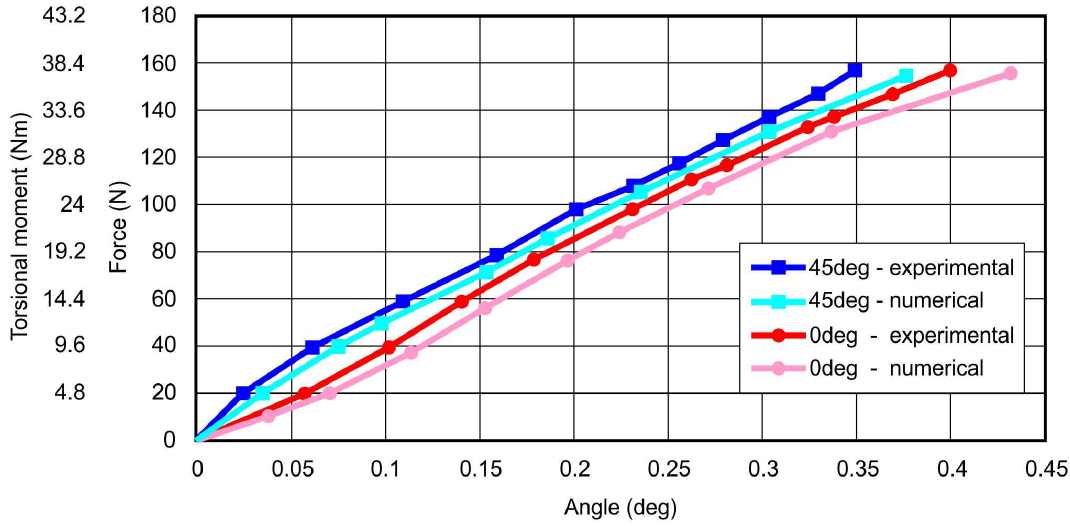
Figure 18. Set of representative equilibrium paths.